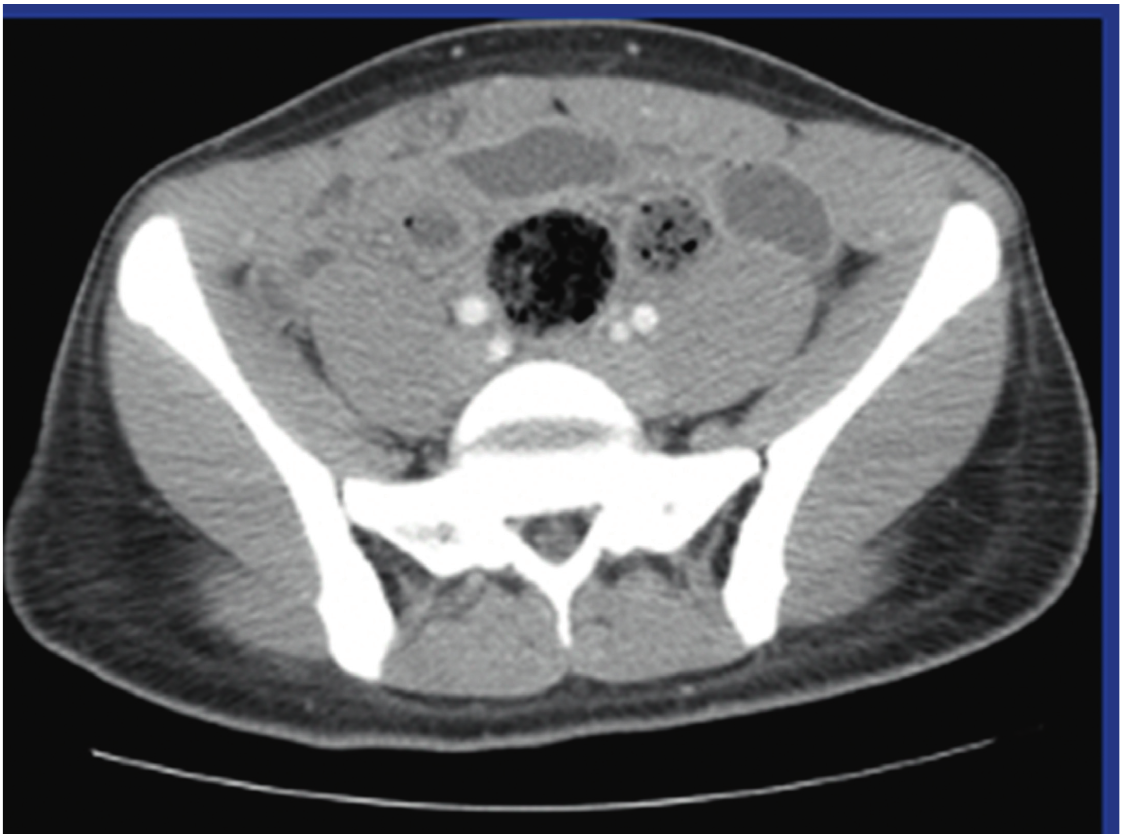
Figure 1: CT of the abdomen and pelvis with contrast showing distended loops of small bowel with wall thickening, enhancement, decompressed loops of bowel distally, and fecalization of small bowel.